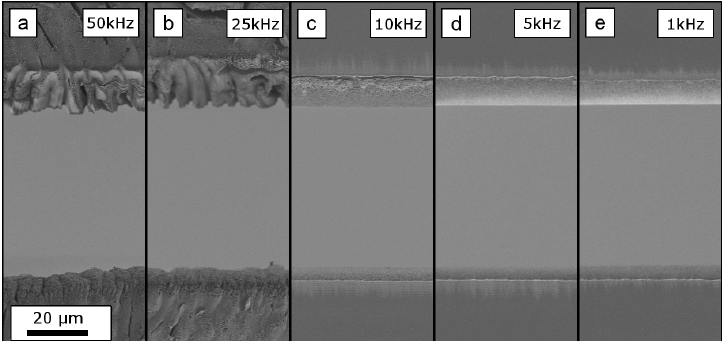
Figure 3. SEM details, as indicated in Figure2, show the edges above and below the central rectangular cut in a 25.4 µ m-thick Upilex-S VDA foil. The cuts were processed with a constant total energy input, hence, decreasing pulse repetition rates whilst increasing the number of scan repetitions (corresponding to increasing machining times). ( a , b ) show massive damage, cracks and molten structures. In ( c ) local molten areas are observable on the upper edge. In ( d , e ) both edges exhibit clean cutting surfaces. The scale bar indicated in ( a ) applies to all figures.